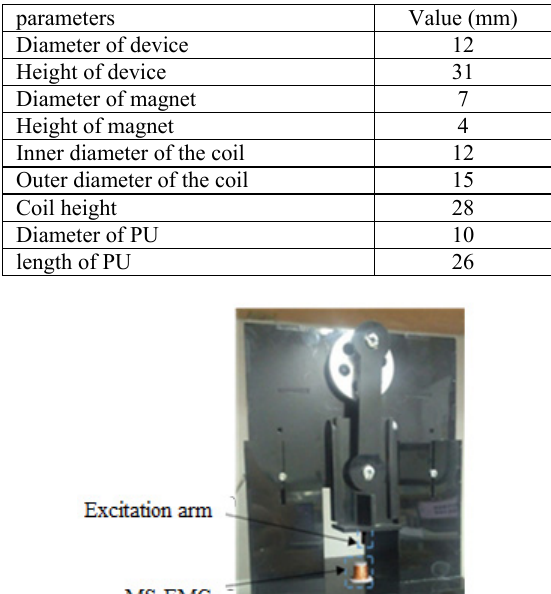
Table 1. Dimensional parameters of MS-EMG